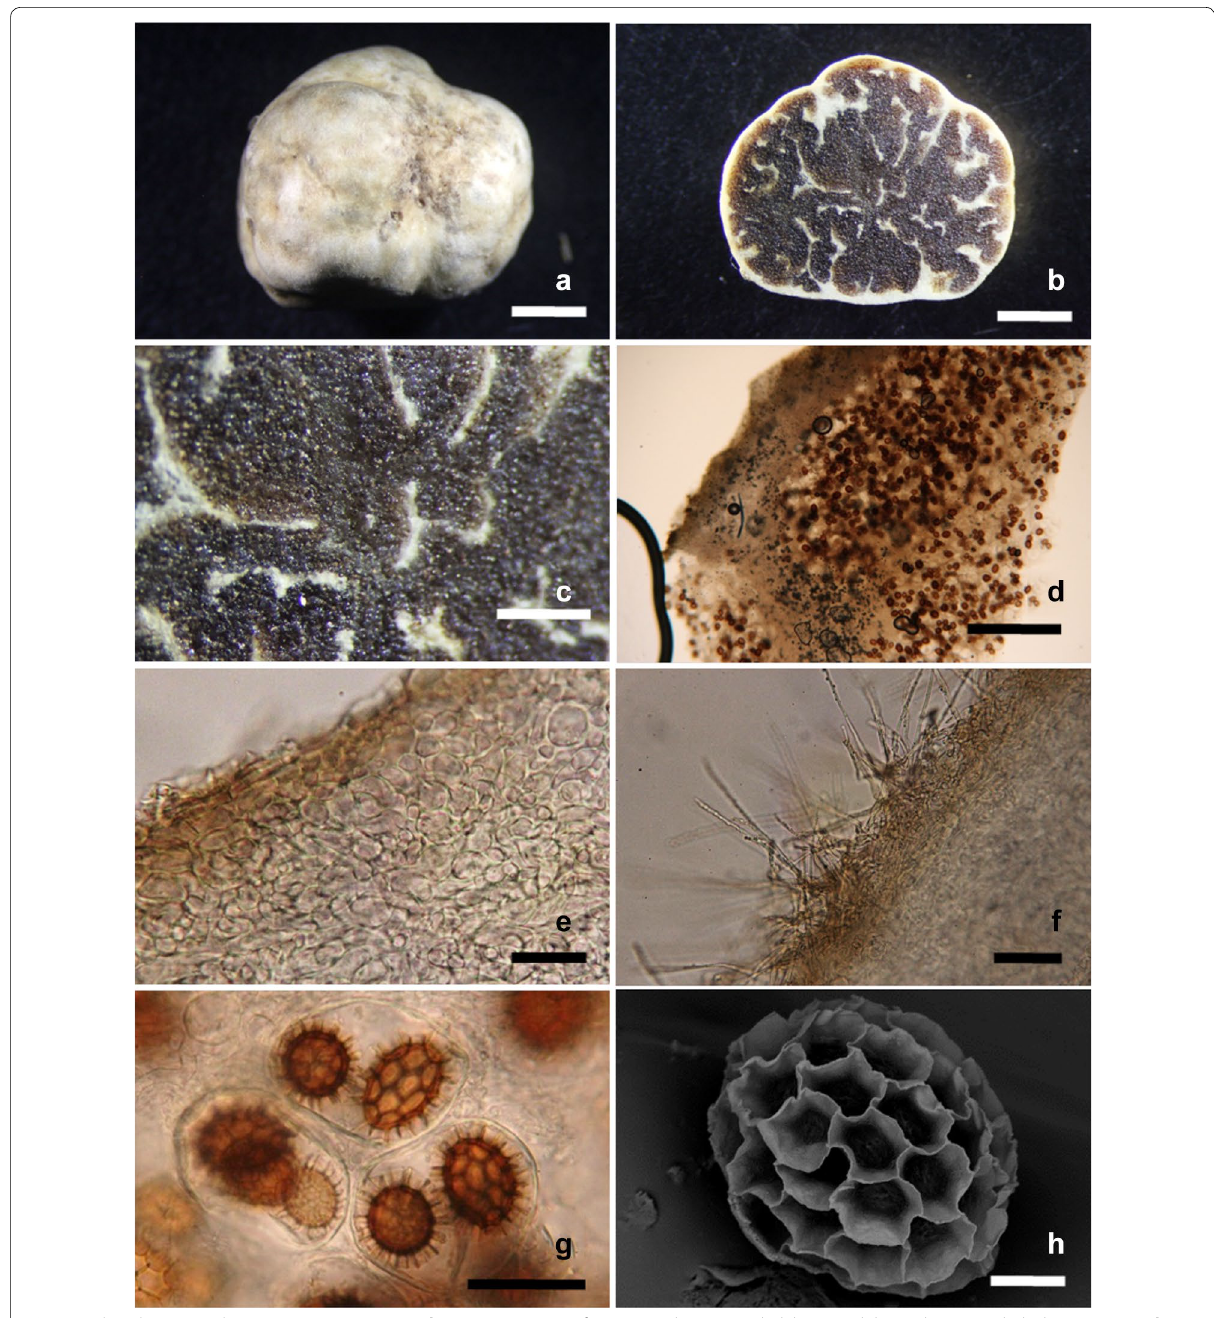
Fig. 1 Tuber elevatireticulatum . a Mature ascocarp. b , c Cross section of ascocarp showing a dark brown gleba with narrow, light brown veins. d Section of peridium and gleba. e Pseudoparenchymatous tissue of peridium. f Hyphae‑like hairs arising from outermost cells. g Ascospores. h Scanning electron micrograph of an ascospore. Bars: a , b 3.5 mm; c 1.5 mm; d 500 µm; e – g 50 µm; h 10